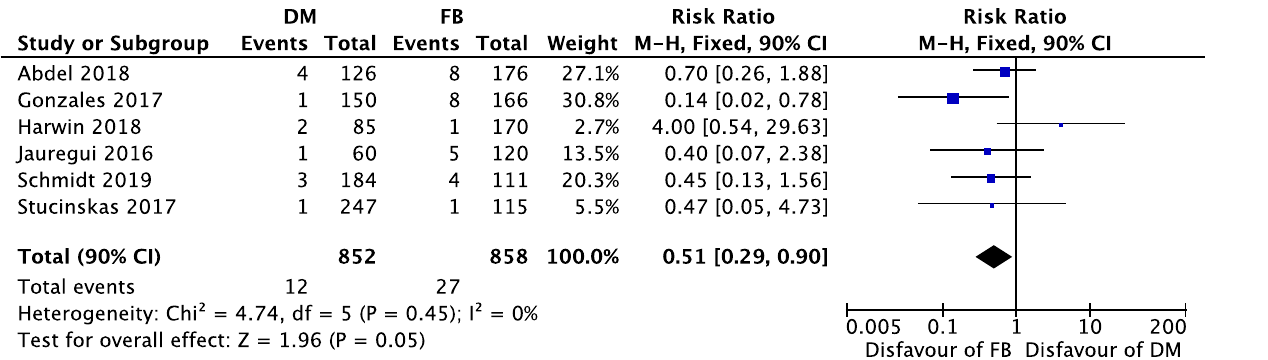
Figure 5. Forest plot for aseptic